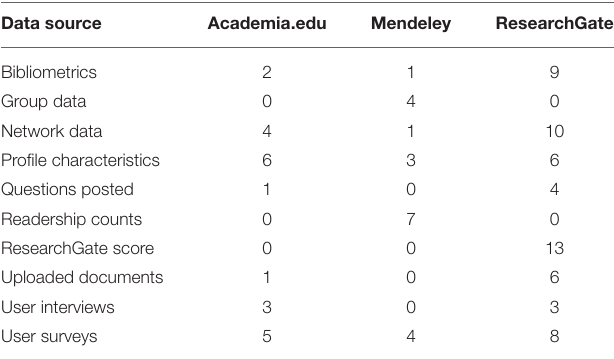
TABLE 1 | Frequency of data types used in the studies, cross-tabulated according to